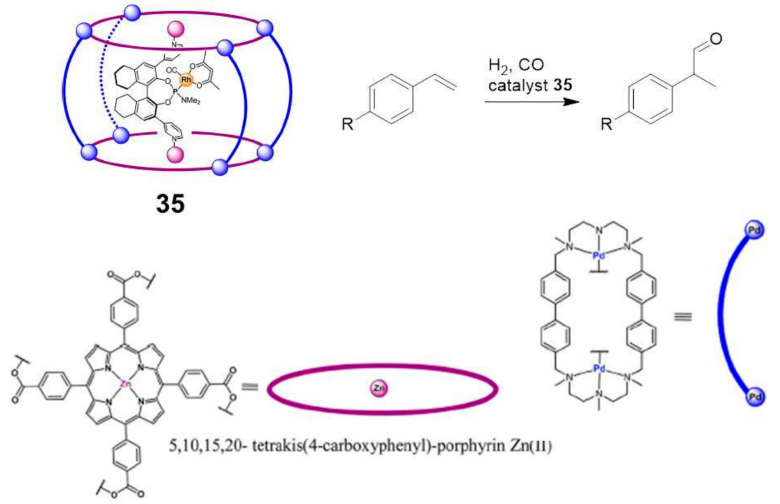
Figure 5. Representation of the capsule 35 containing Rh catalyst (adapted with permission from Ref. [33]. Copyright 2008 American Chemical Society) and hydroformylation of styrenes.